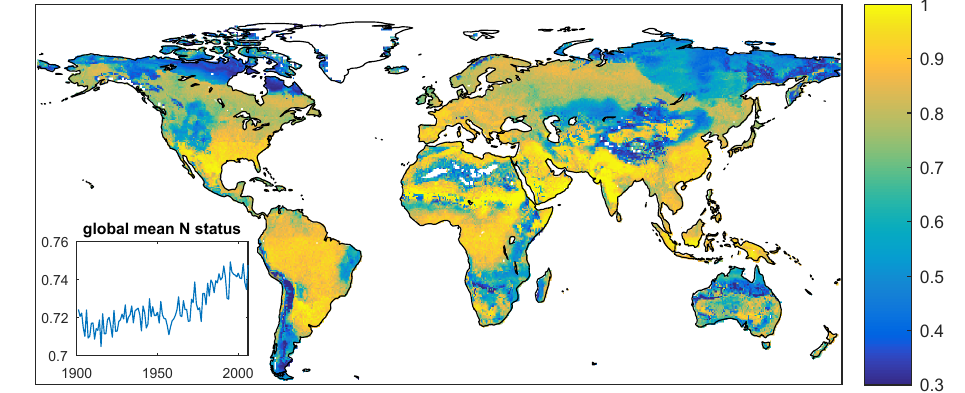
Figure 5. Ecosystem N status for the true historical simulation ( + Ndep + clim + CO 2 ) averaged over the period 1997–2006. Lower values indicate stronger N limitation (see main text). The inset shows global mean N status over time during the simulation period.